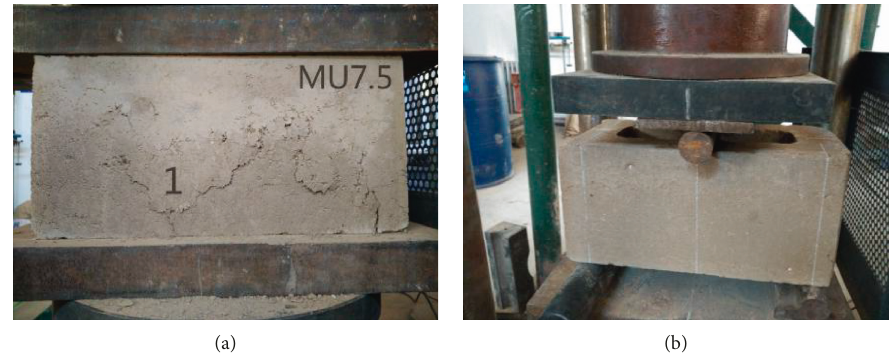
Figure 3: Testing of the individual HCCSEBs under (a) compression and (b) three-point bending.